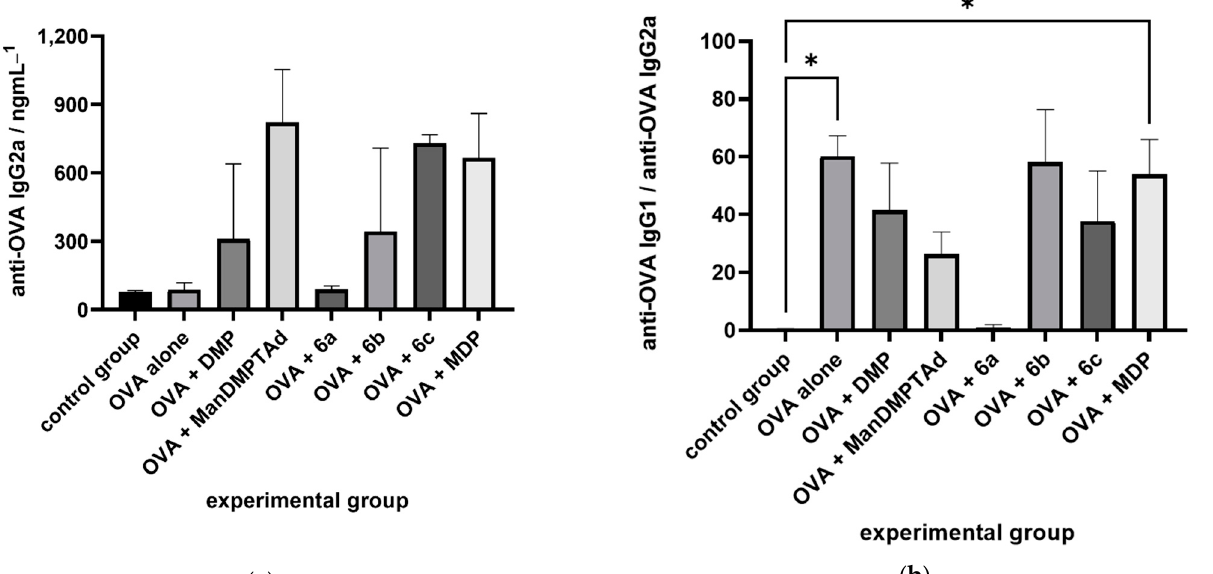
Figure 3. The effect of synthesized DMPs on the production of the anti-OVA IgG2a subtype ( a ) and IgG1/IgG2a ratio ( b ) in BALB/c mice immunized with OVA as an antigen. Bar graphs represent the average values of individual mice from each group ( n = 5). * p < 0.05 denotes statistical significance between indicated groups.